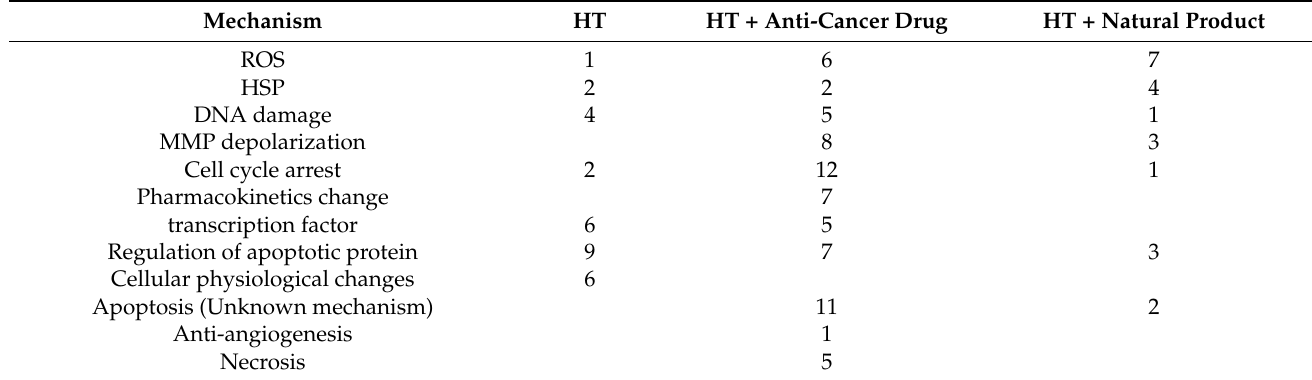
Table 4. Mechanisms of HT and Its combined therapy (number of